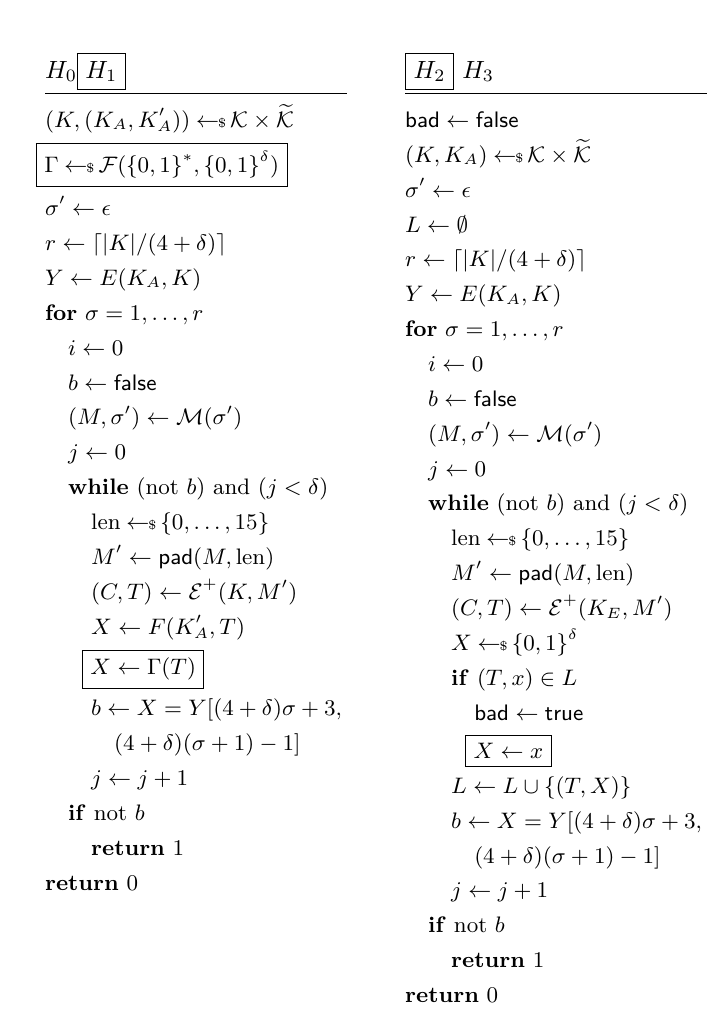
Figure 5.3: Games used in the proof from Section